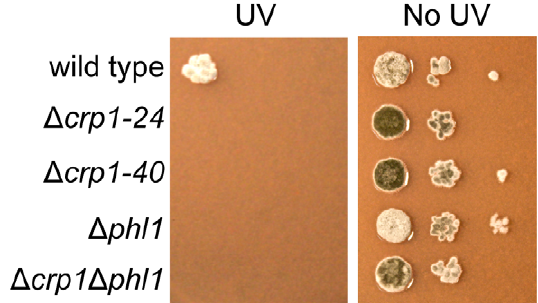
Figure 9. Photoreactivation of CRP1 . Ten-fold serial dilutions of conidia (10 3 , 10 2 , and 10) from each strain were inoculated on V8-agar medium, and exposed to UV light (3 mW/cm 2 , 90 min). After UV irradiation, the plates were placed in constant light for three